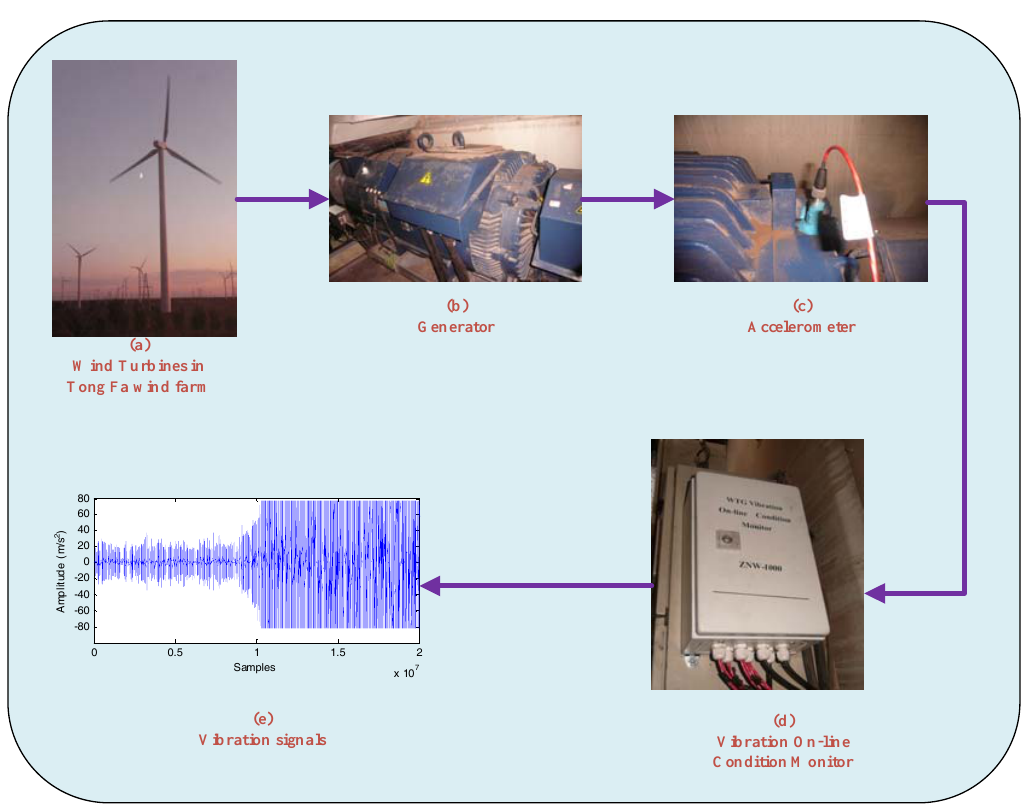
Figure 7. The vibration signals acquisition process in wind turbine generator bearing.